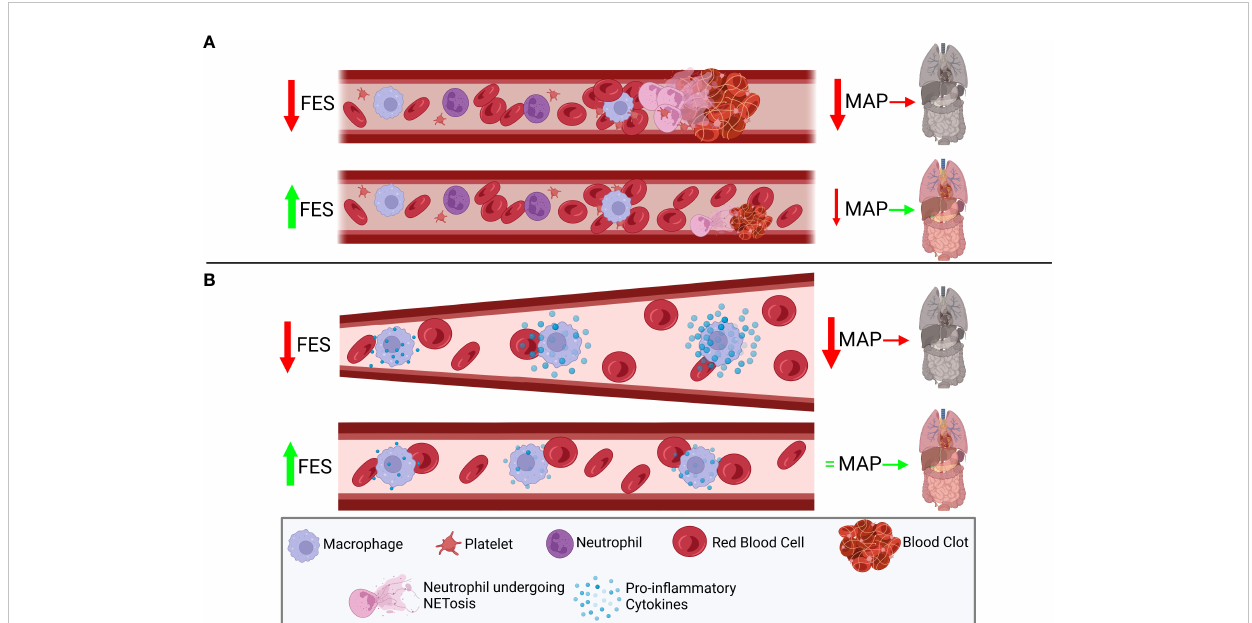
FIGURE 1 Decreased FES levels may correlate with worse septic outcomes by modulating host immune and coagulation pathways. (A) FES has been shown to play a role in limiting coagulation cascades through modulation of platelets and we hypothesize a role for FES in decreasing NETosis from neutrophils. Therefore, low FES expression is hypothesized to correlate with reduced lysis of blood clots, and an increase in NETosis in both a platelet-dependent and – independent manner, thus leading to reduced mean arterial pressure (MAP), leading to end organ damage. However, in patients with high FES expression, there is hypothesized to be reduced NETosis, and increased disaggregation of platelets, leading to a less dramatic impact on MAP, and improved perfusion of end organs. (B) FES has been shown to suppress the toll-like receptor (TLR) 4 signaling cascade, which leads to the production of pro-in fl ammatory cytokines regulated by NF- k B and IRF3. In patients with low FES expression, it is hypothesized that this signaling cascade will be poorly regulated, leading to the over-activation of the TLR4 cascade, stimulated by components of bacterial cell walls